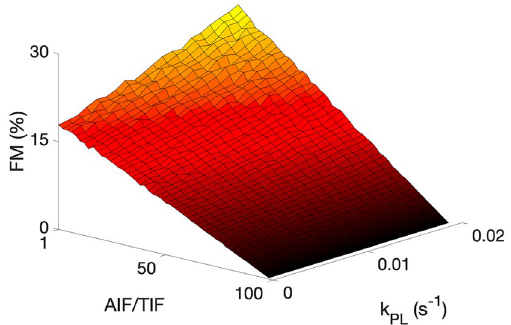
Figure 7. Simulation results showing the variation in FM (%) as both AIF/TIF and kPL are varied. SNR and B1 error are assumed to be 100, and 1, respectively. Generally, an increase in metabolism is observed as perfusion decreased and kPL increased.